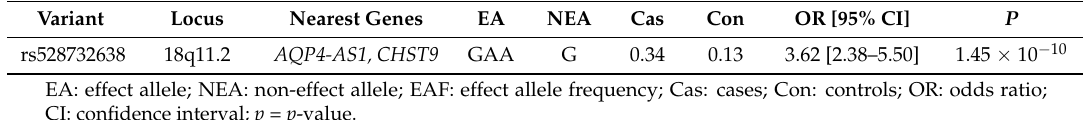
Table 1. The lead variant of a single locus, rs528732638, showed genome-wide significance. Variant Locus Nearest Genes